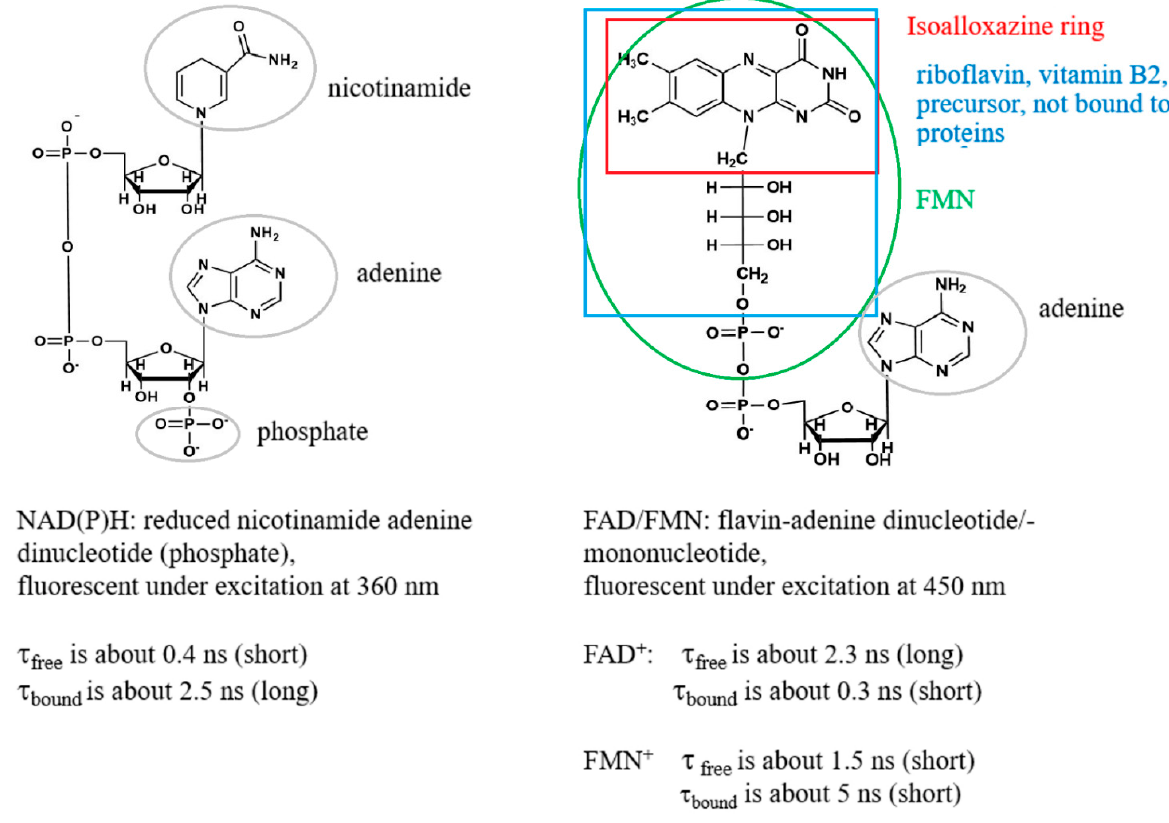
Figure 1. Intracellular coenzymes that play key roles in energy metabolism and metabolic FLIM and their spectral and lifetime characteristics obtained from published data [10,12–15]. The figure was prepared using the software “ChemDraw (version 20.1.0.110)”.